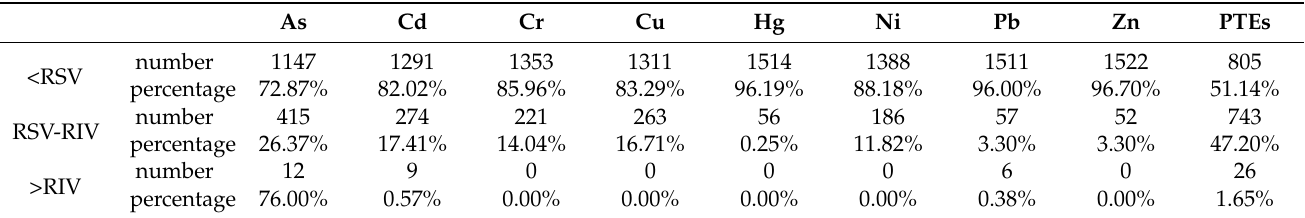
Table 4. The number and percentage of sites over the national environmental quality of